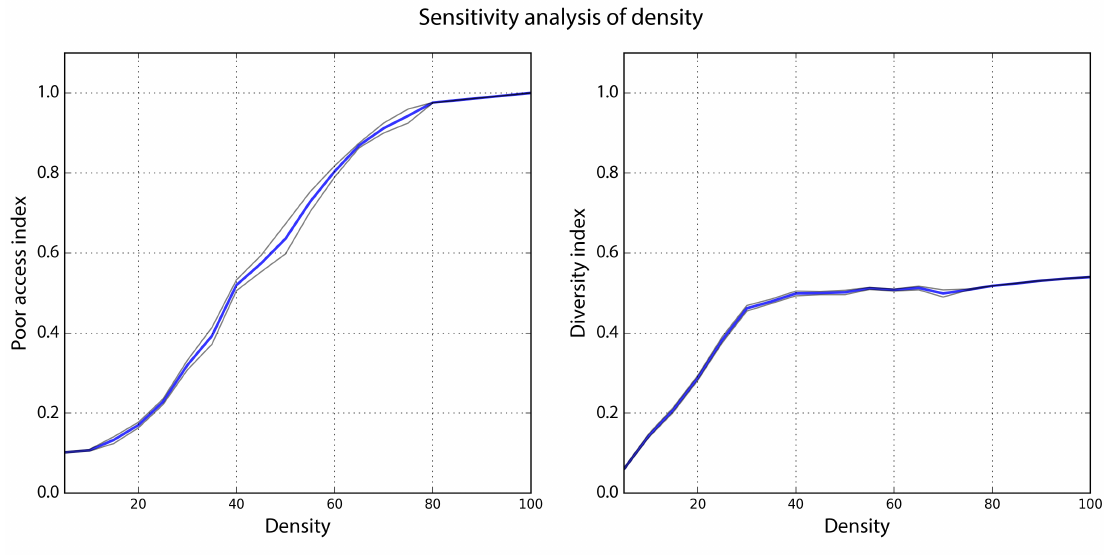
Figure 9. The values for poor access indicator and diversity indicator on which the model converged over 50 runs given different density parameter values, with all other parameters held at their baseline values. The mean value is blue and the gray lines depict the 95% confidence